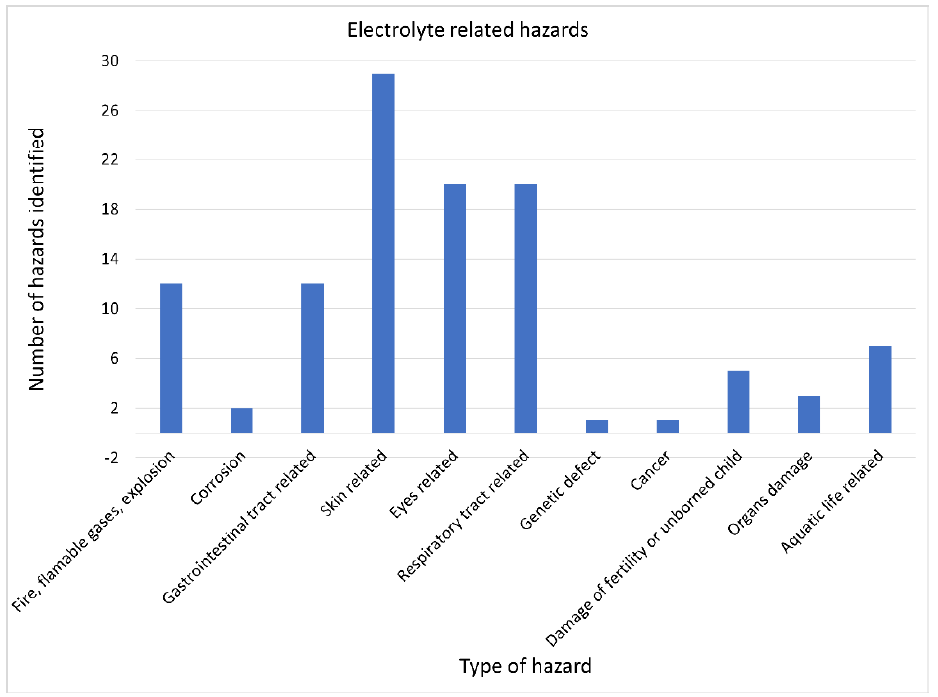
Figure 11. The number of the hazards identified versus the type of hazard for electrolyte materials in Mg–S cells. Table 1. Materials for components of Mg–S